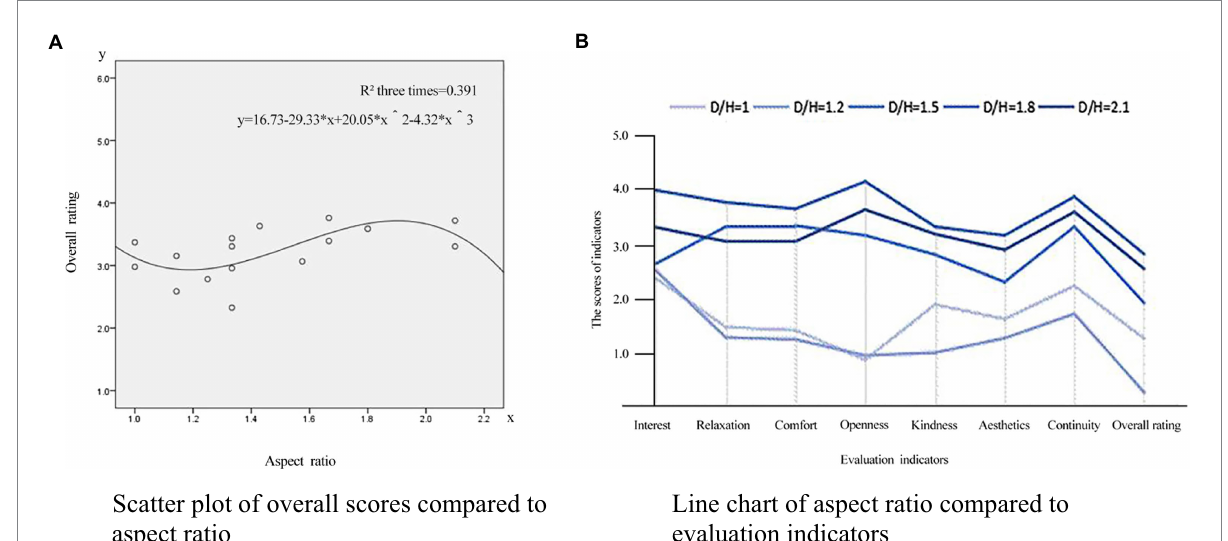
FIGURE 2 Scatter analysis of the aspect ratio against the overall rating. (A) Scatter plot of overall scores compared to aspect ratio. (B) Line chart of aspect ratio compared to evaluation